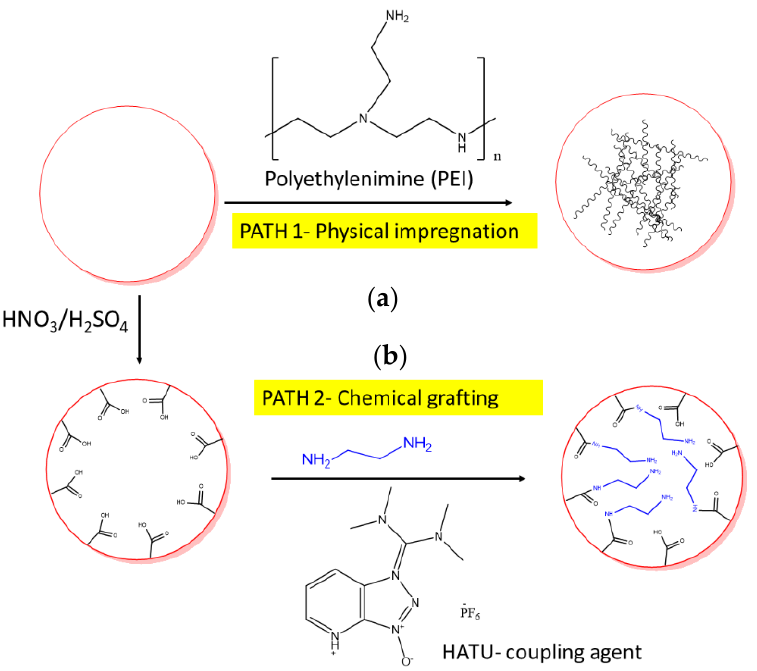
Figure 8. The structure of amine functionalized mesoporous carbons by ( a ) Physical impregnation of PEI, and ( b ) Chemical grafting of EDA (Reprinted with permission from ref. [206]).